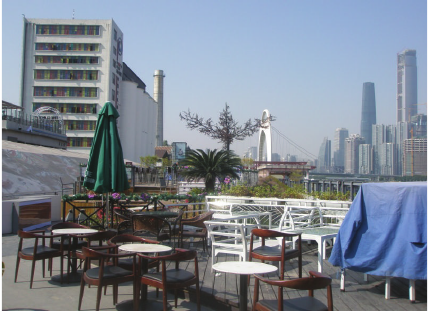
Figure 13: Rriverside view of Party Pier.